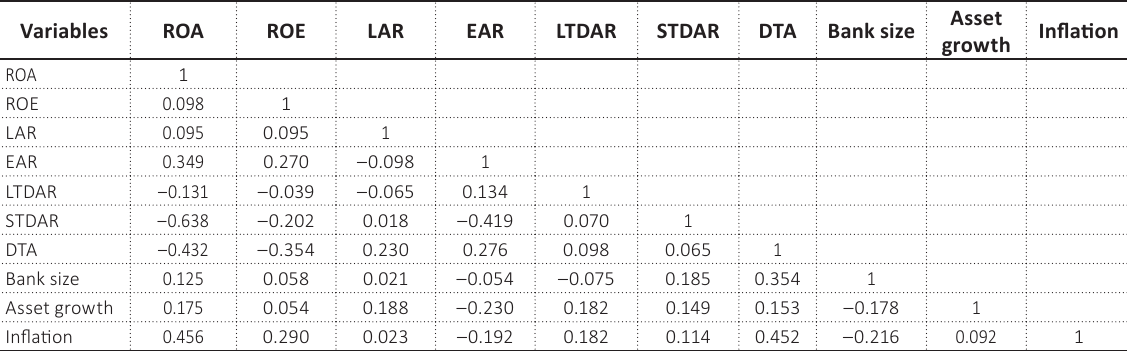
Table 3. Pearson correlation